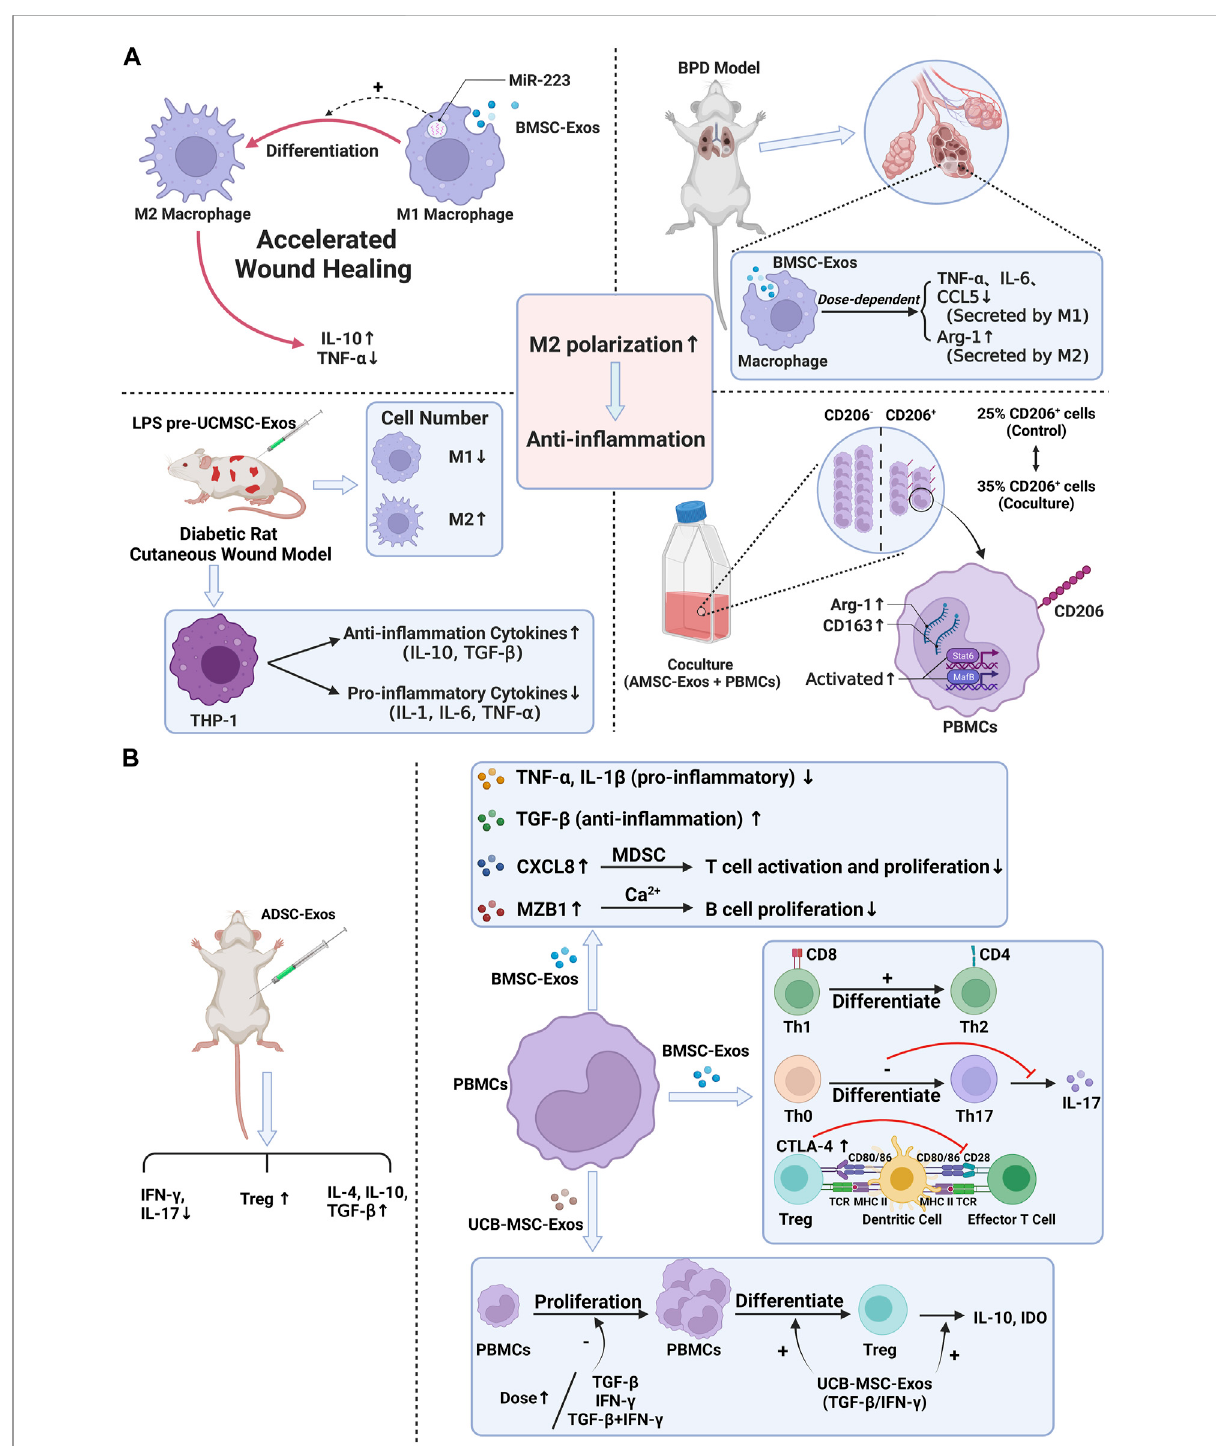
FIGURE 3 Anti-in fl ammation ability of stem cell exosomes. Panel (A) : Stem cell exosomes play anti-in fl ammation roles by inducing M2 macrophage polarization.BMSC-ExosinducedM2macrophagepolarizationthroughmiR-223,resultinginhigherIL-10levelsandlowerTNF- α levels.Afteruptake ofBMSC-Exos,thepro-in fl ammatoryfactorsdecreased,andtheanti-in fl ammationfactorsincreased.UndertheinductionofLPSpre-UCMSC-Exos, the M1 macrophages were decreased, while the M2 macrophages were increased. THP-1 produced more anti-in fl ammation cytokines and fewer pro-in fl ammatory cytokines. When PBMCs were cocultured with AdMSC-Exos, CD163, Arg1, and CD206-positive cells were increased. M2 macrophage – speci fi c transcription factors were activated. Panel (B) : Stem cell exosomes play anti-in fl ammation roles by regulating the